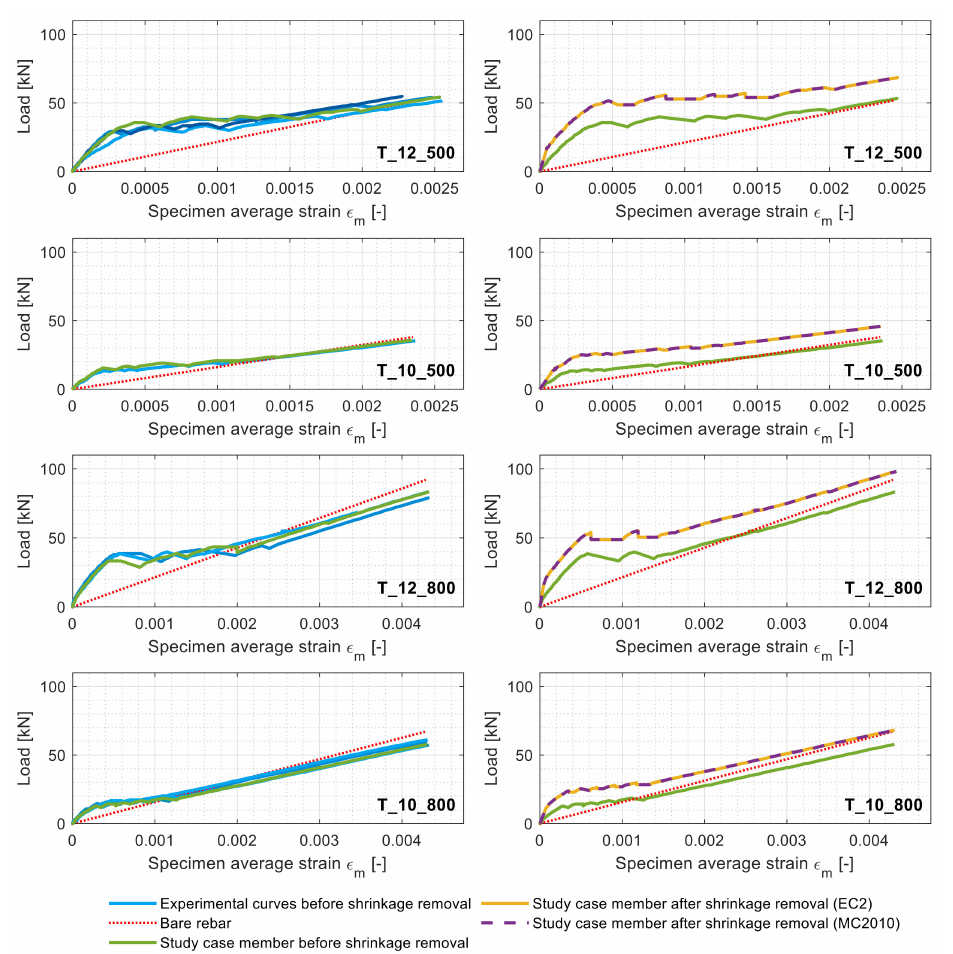
Figure 4. Load–specimen average strain diagrams of all the members ( left column ) and those of the study case members ( right column ) before and after shrinkage elimination.